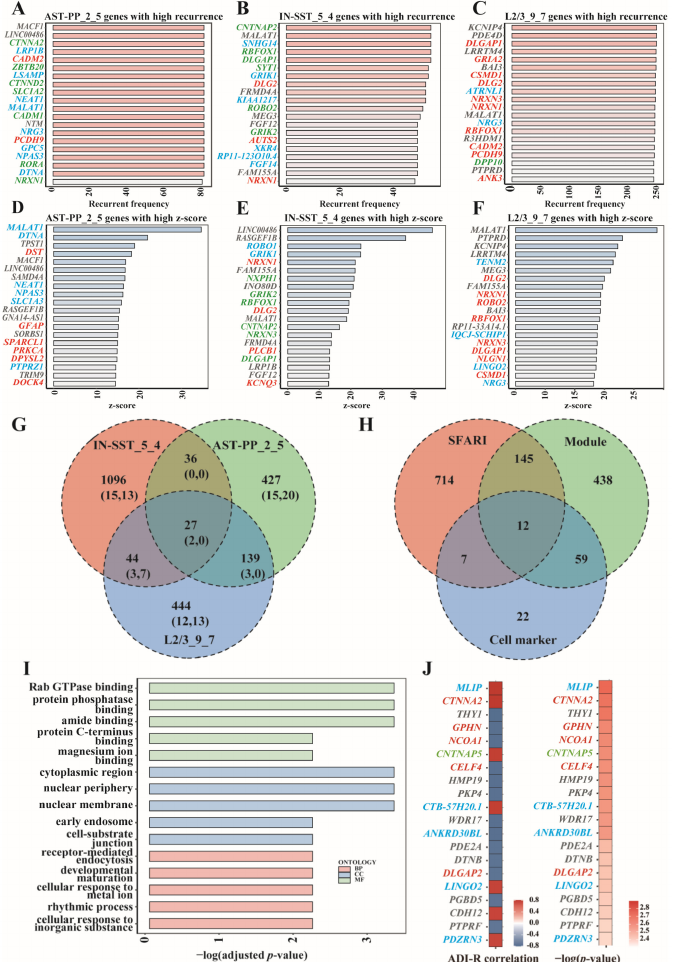
Figure 6. Comprehensive analysis of gene modules AST-PP_2_5, IN-SST_5_4, and L2/3_9_7. ( A – C ) The bar plot of the top 20 recurrent frequency genes in modules AST-PP_2_5, IN-SST_5_4, and L2/3_9_7. SFARI genes in red, cell markers in blue, and the intersection of the two in green. ( D – F ) The bar plot of the top 20 z-score genes in modules AST-PP_2_5, IN-SST_5_4, and L2/3_9_7. SFARI genes in red, cell markers in blue, and the intersection of the two in green. ( G ) Venn plot of genes in modules AST-PP_2_5, IN-SST_5_4, and L2/3_9_7. The number outside the bracket indicates module genes, the first number in the bracket indicates top 20 recurrent frequency genes, and the second number indicates top 20 z-score genes. ( H ) Venn plot of the module genes in module L2/3_9_7, cell markers, and SFARI genes. ( I ) Functional analysis of gene module L2/3_9_7. ( J ) The Pearson’s correlation coefficients and associated p values of the top 20 genes which are correlated with ASD clinical severity in module L2/3_9_7. SFARI genes in red, cell markers in blue, and the intersection of the two in